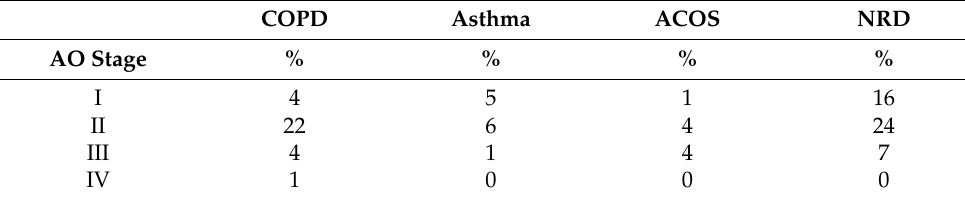
Table 3. Obstruction severity prevalence for each reported physician diagnosis. COPD Asthma ACOS NRD